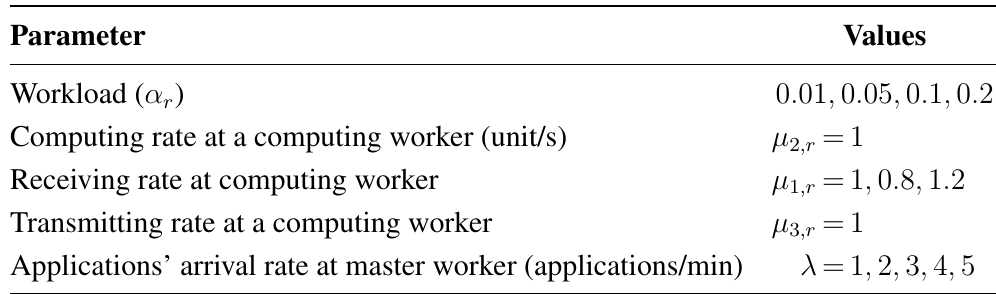
Table 2. Illustrative Parameter